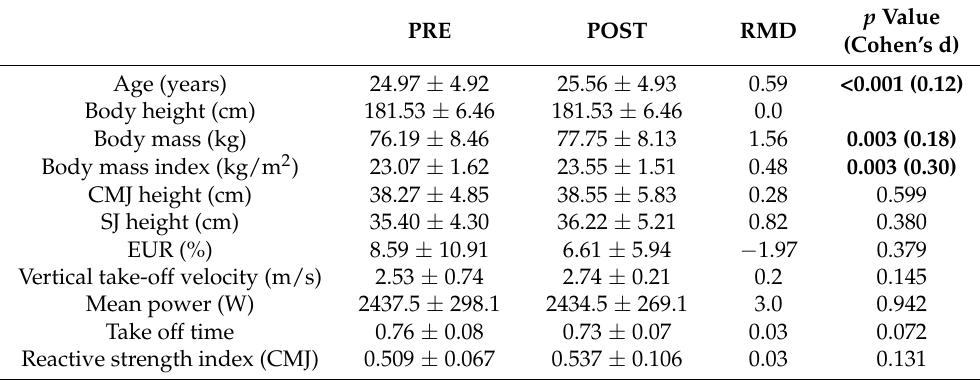
Table 2. Comparison of anthropometric and selected sport-related physical performance measures at baseline, from pre-lockdown, (PRE) to post-COVID-19 lockdown (POST).